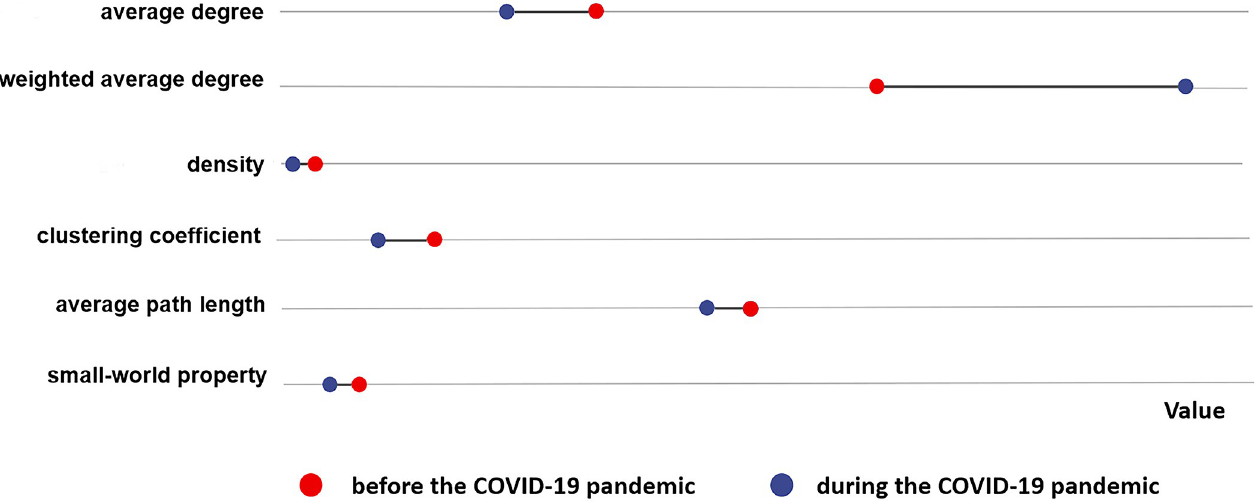
Fig 4. Indicator changes in courses with decreased interaction scale from before the COVID-19 pandemic until the outbreak.